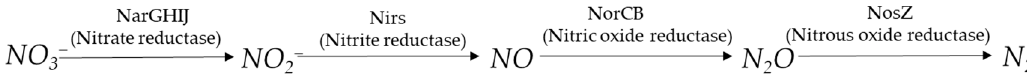
− to N 2 (nitrogen